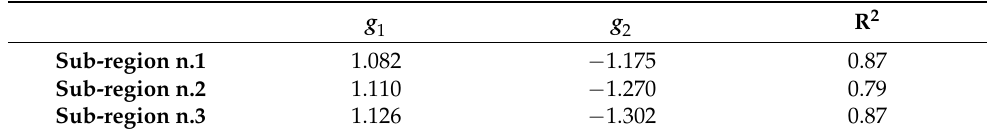
Table 3. Coefficients g 1 and g 2 of the regression model between β and n and the coefficient of determination, R 2